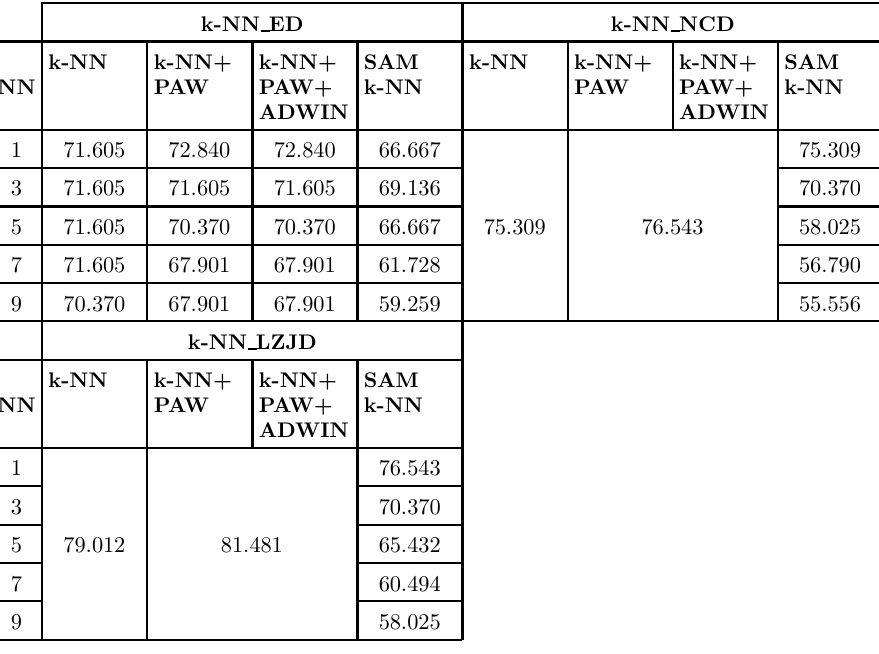
Table 2. K-nearest neighbour classification using Euclidean distance, Normalized Compression Distance, and Lempel-Ziv Jaccard Distance for the measurements taken from the second patient k-NN ED k-NN NCD k-NN k-NN+ k-NN+ SAM k-NN